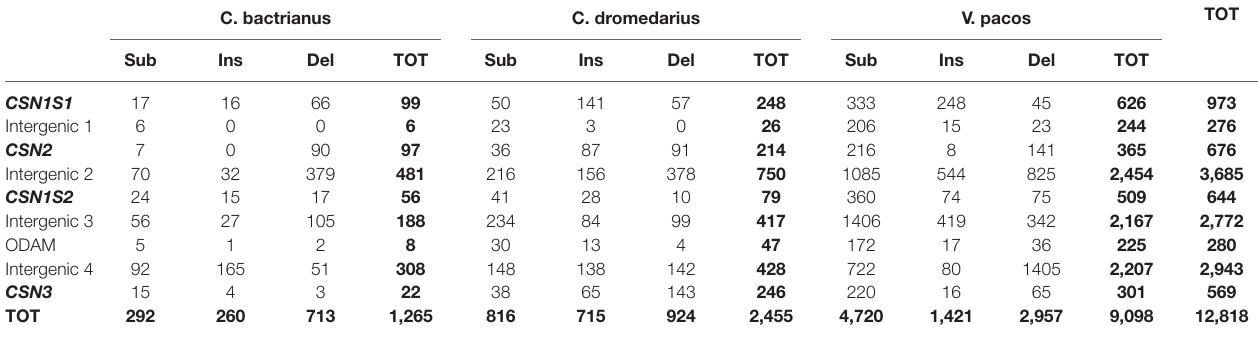
TABLE 3 | Number of polymorphic sites differentiated in substitutions (Sub), insertions (Ins), and deletions (Del) found in the casein cluster region of Bactrian, dromedary, and alpaca by the comparative genomic analysis using the wild camel sequence (AGVR01039100.1) as reference, including the total numbers of polymorphic sites (TOT) within gene by species and in